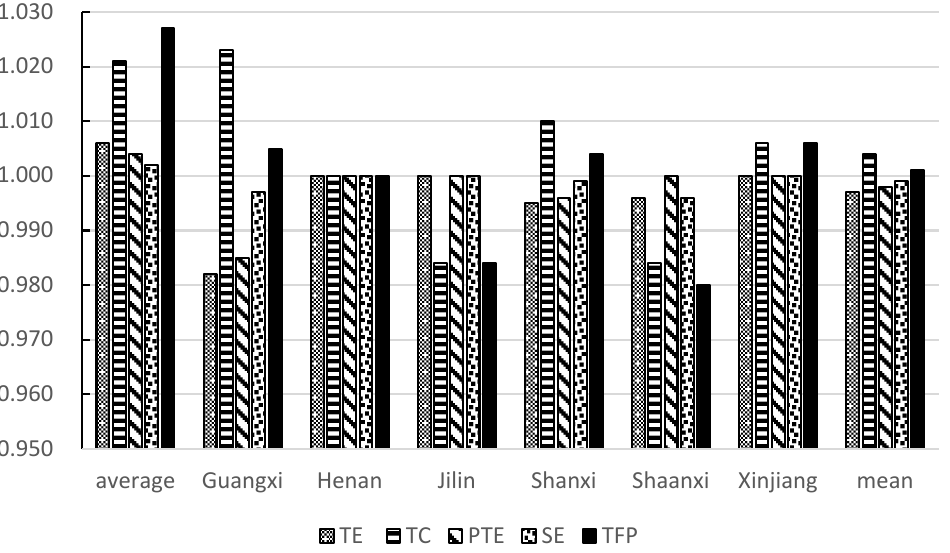
Figure 1. Efficiency changes in free-range raw milk production areas in China from 2004 to 2020.